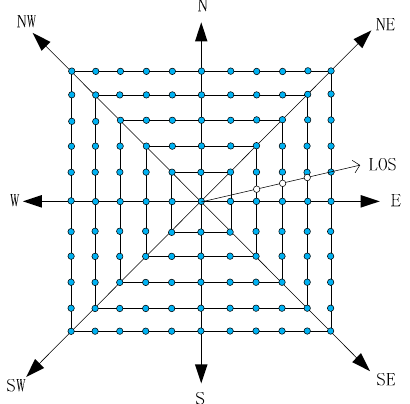
Figure 3. Viewshed computation in the line-of-sight (LOS) algorithm. The algorithm draws a ray from the viewpoint (i.e., the center point of the grid) to the target point (i.e., the outermost point intersected by the ray), and the height of the reference point in the LOS is obtained by interpolation.